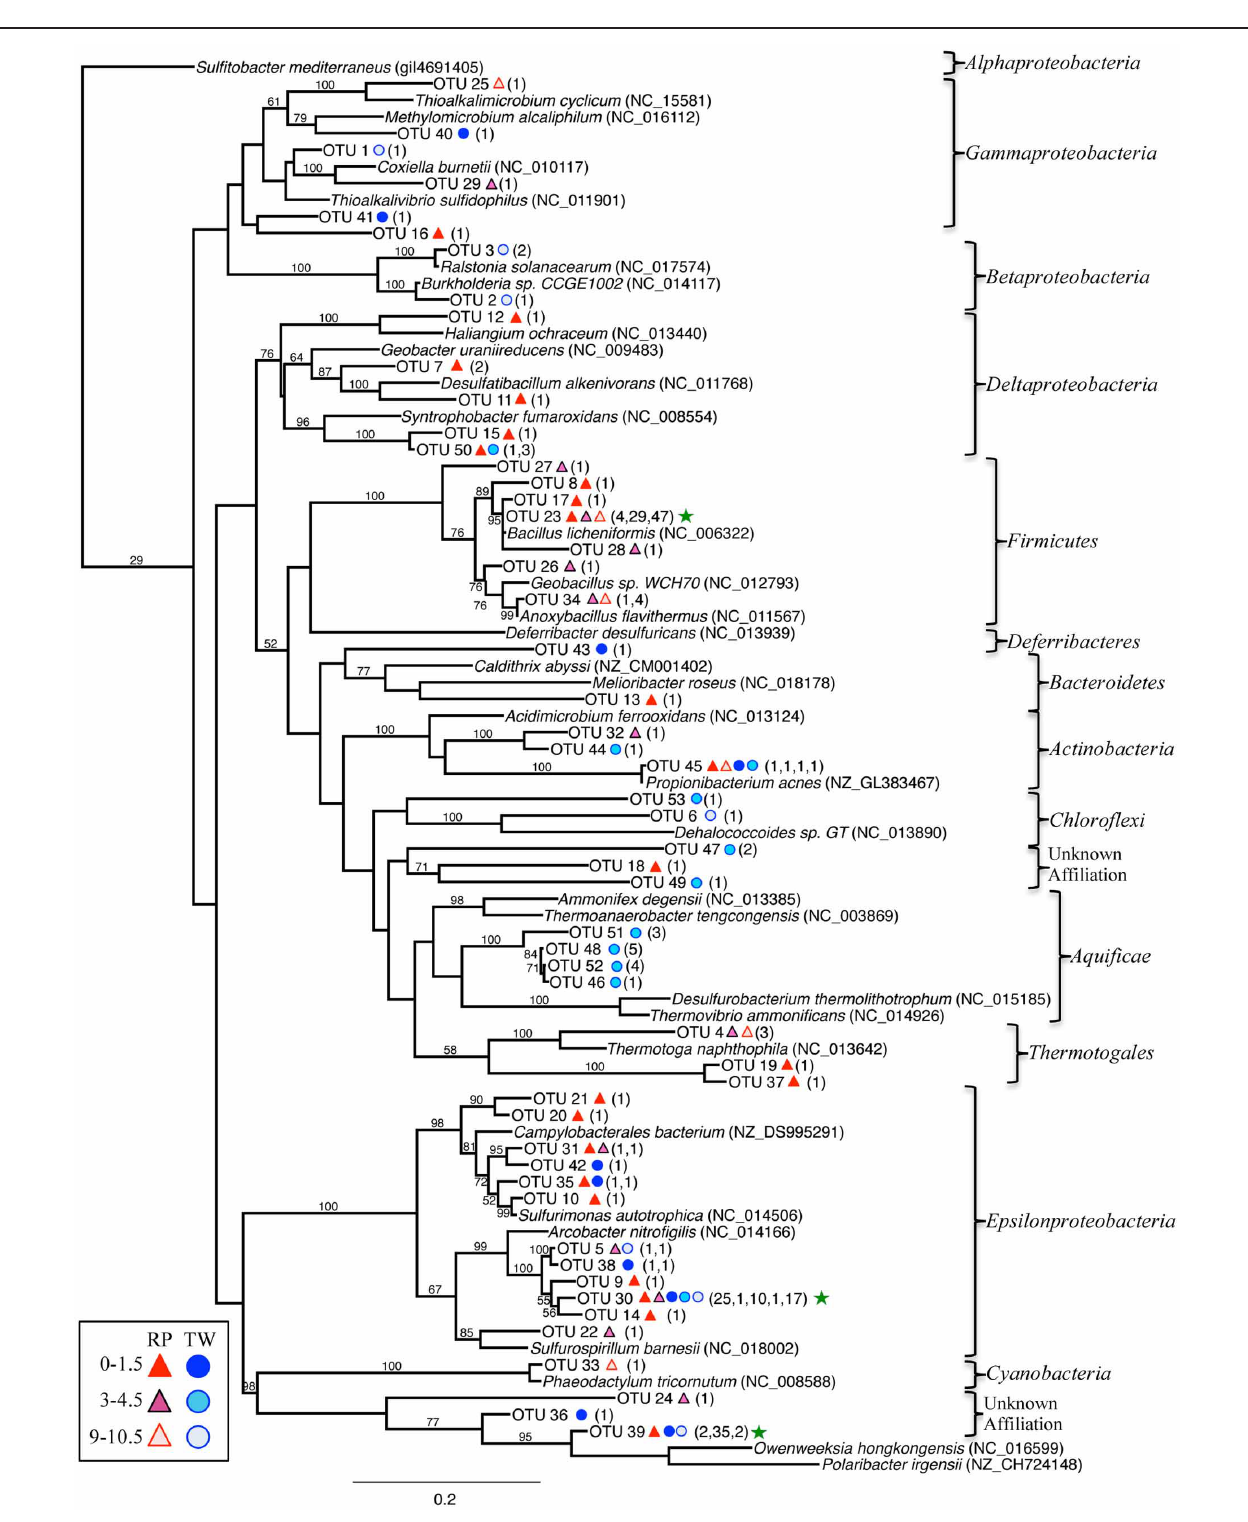
FIGURE 5 | Maximum-likelihood phylogenetic tree of closest relatives found for representatives from the 16S rRNA bacterial clone libraries. OTUs are defined by a 97% similarity cutoff. Symbols next to the OTUs from this study represent the samples from which they were recovered, as